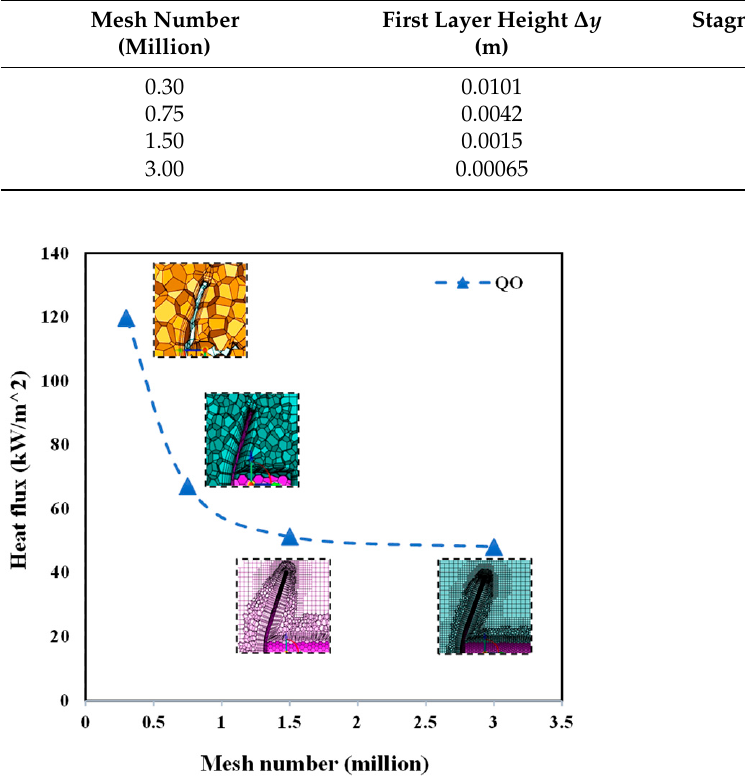
Figure 6. Mesh independence verification.